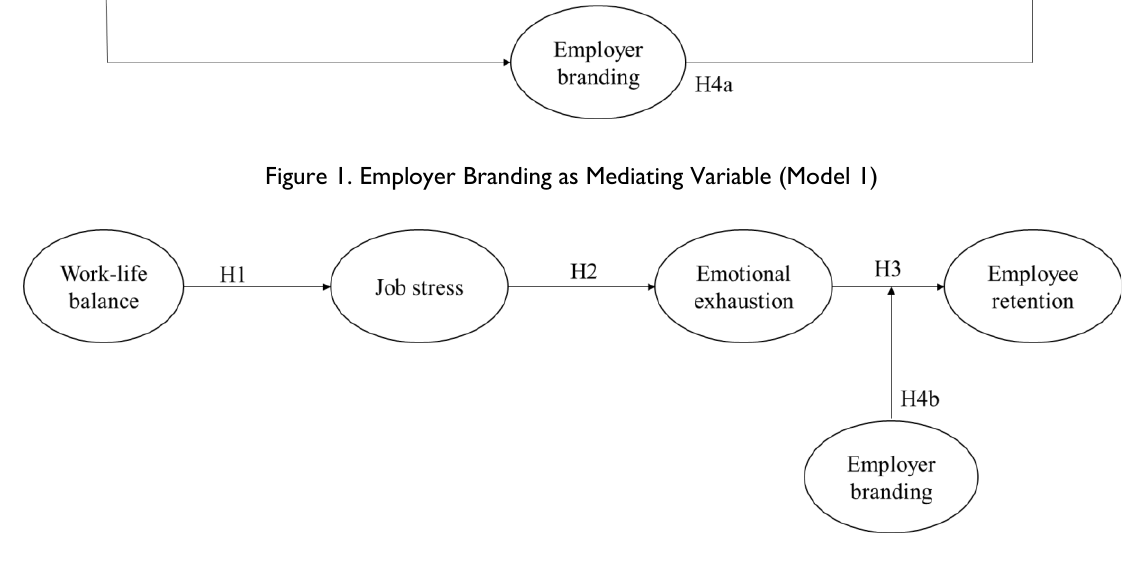
Figure 2. Employer Branding as Mediating Variable (Model